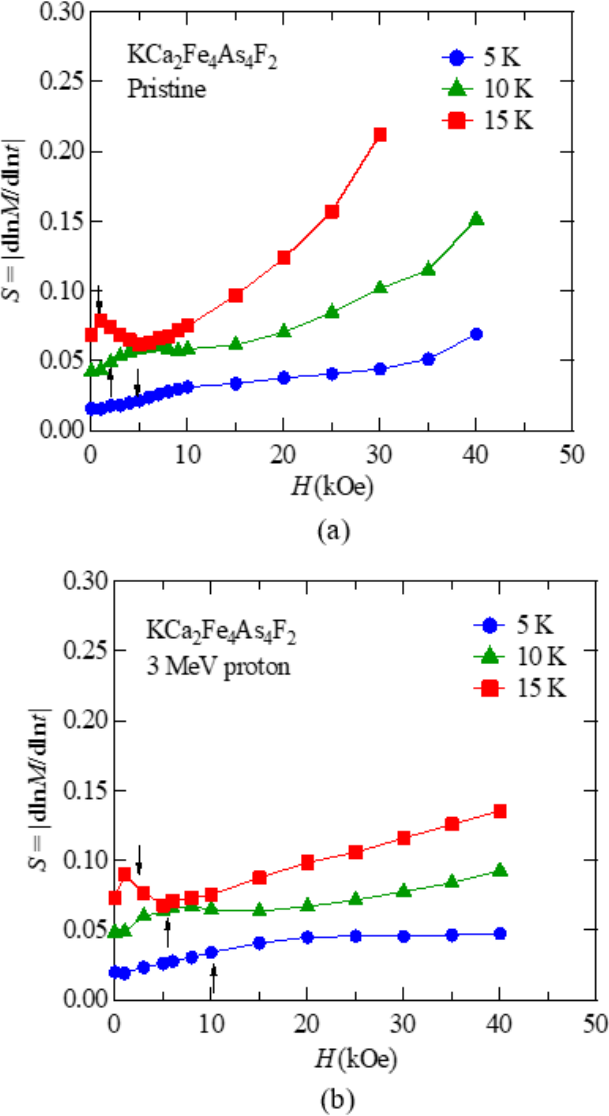
Figure 5. Magnetic field dependence of the normalized magnetic relaxation rate S = |dln M ( t )/dln t | at T = 5, 10, and 15 K under H // c in ( a ) the pristine and ( b ) 3 MeV proton irradiated (3 × 10 16 ions/cm 2 ) KCa 2 Fe 4 As 4 F 2 . The self-fields at 10 and 15 K of both the pristine and proton irradiated samples are indicated by arrows.